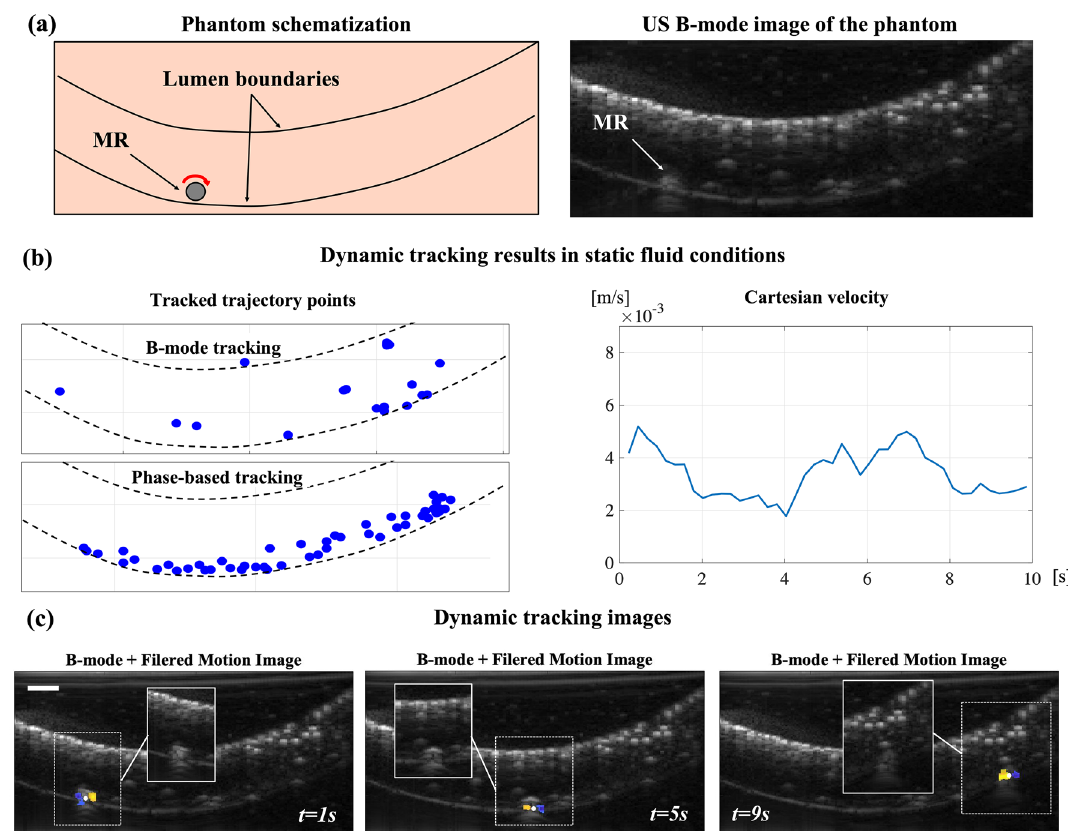
Figure 4. Dynamic MR tracking in echogenic background. ( a ) Schematization of phantom for tracking experiments and corresponding B-mode image. ( b ) Results of trajectory tracking in static fluid conditions. The tracked trajectory points graph show how B-mode tracking fails due to static objects with higher contrast than the MR (e.g., lumen boundaries). The phase-based approach succeeds in tracking the MR along the entire trajectory. The cartesian velocity plot shows an almost constant trend, suggesting that the MR performs a nearly pure rolling motion. ( c ) Dynamic tracking images for different time instants during the experiment. The filtered motion images show MR contrast enhancement enabling robust detection even when the MR is barely visible in standard B-mode images (shown in image insets). The scale bar is 1